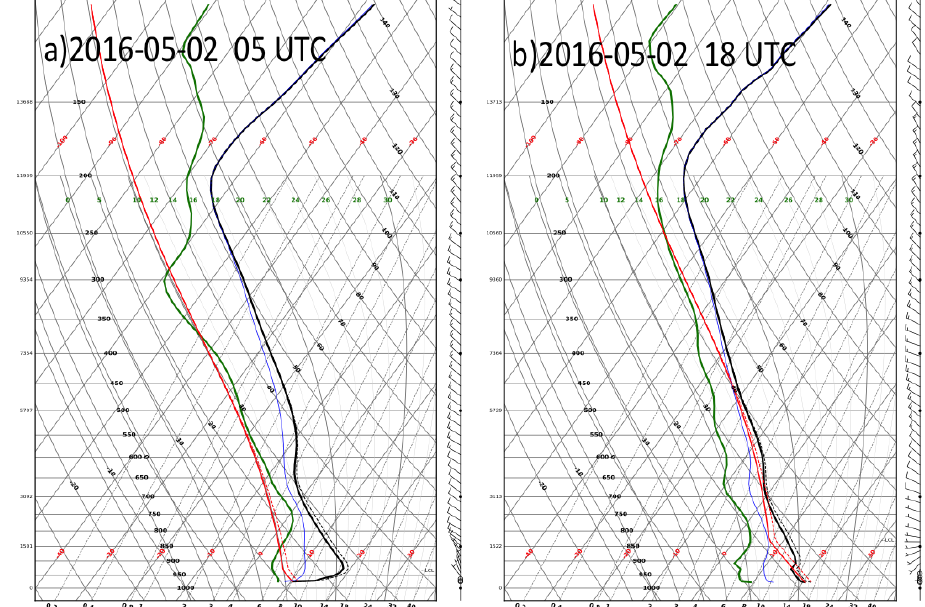
Figure 6. Model sounding at the location 56.689895 N, 111.39035 W at ( a ) 05 UTC on May 2 and ( b ) 18 UTC on May 2. The solid black line in Skew-T is the ambient air temperature, the solid green line is the dew-point temperature and the solid red line is the lifted surface parcel